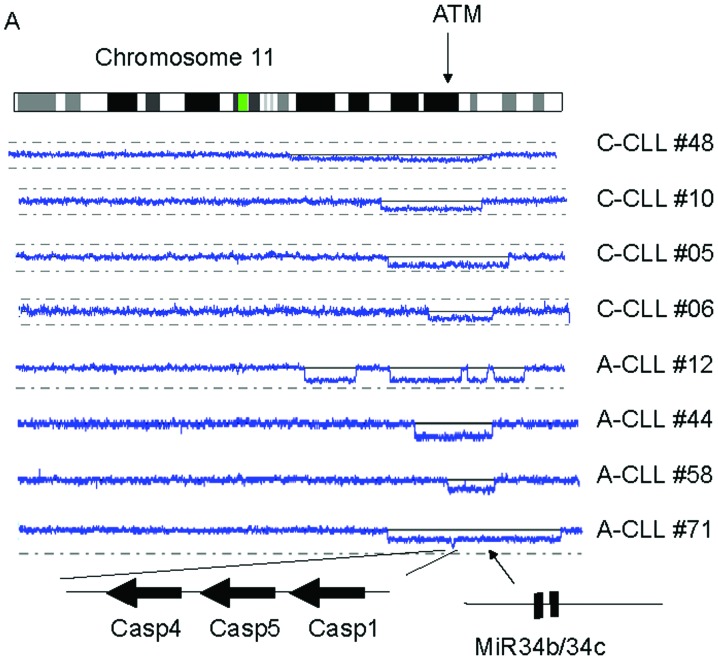
Novel common target candidate genes in CLL. (A) Representative CLL cases with deletion of 11q. SNP-chip analysis (blue lines) is shown with a scheme of the chromosome (top), individual CLL samples and their altered genes (bottom). The arrow on the chromosome panel indicates the position of the ATM gene. At the bottom, the three large arrows show the direction of transcription of the target genes; and the diagonal arrow designates the position of the microRNAs, miR 34b/34c. The CLL case numbers are shown on the right side (A, Asian; C, Caucasian). (B) Representative CLL cases with deletion of 13q. The results of SNP-chip analysis (blue lines) are shown together with the scheme of the chromosome (top). Arrows at the bottom indicate the positions of RB1 gene and the microRNAs, miR 15-a/16-1. The case numbers are shown on the right side (A, Asian; C, Caucasian). (C) Representative CLL cases with deletion of 8p. The result of SNP-chip analysis (blue lines) is shown with the scheme of the chromosome (top) and genes (bottom). The arrow indicates the direction of transcription of the DLC1 gene. The case numbers are shown on the right side (A, Asian; C, Caucasian).